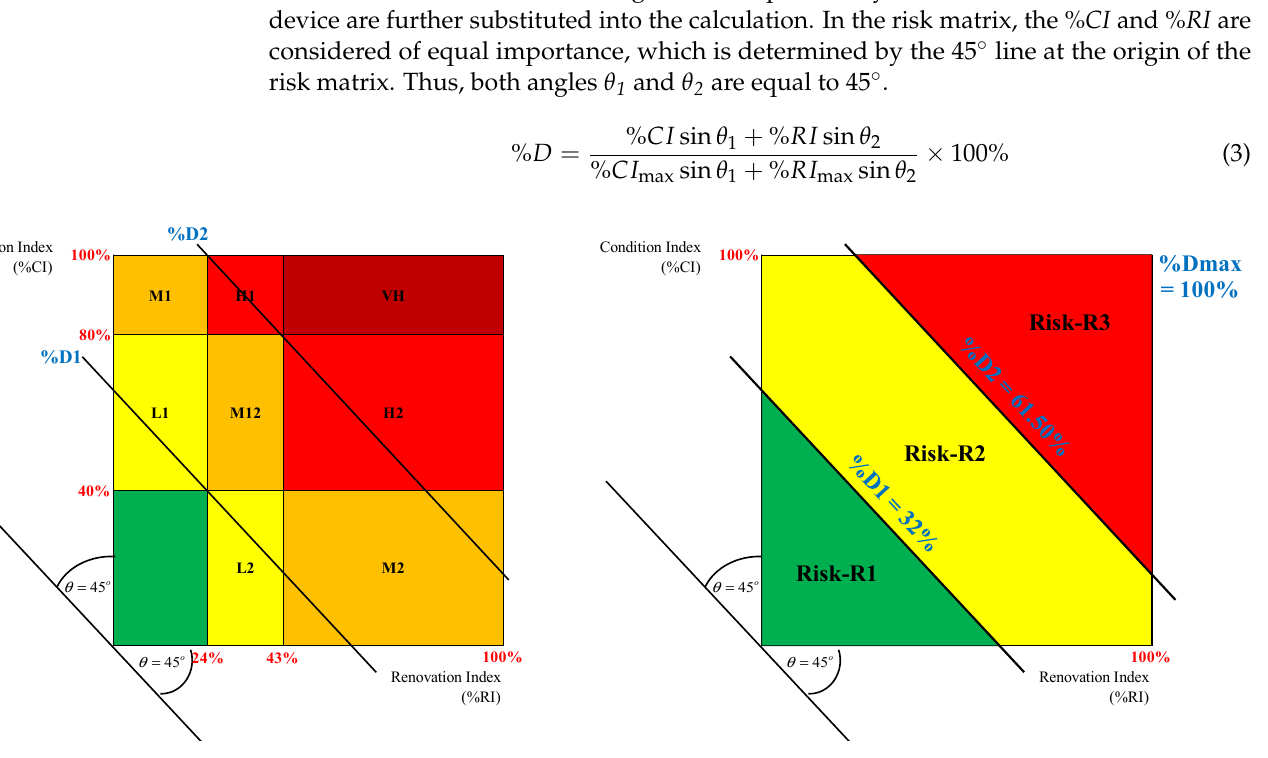
Figure 3. Measurement of the D-distance factor for the failure probability assessment.